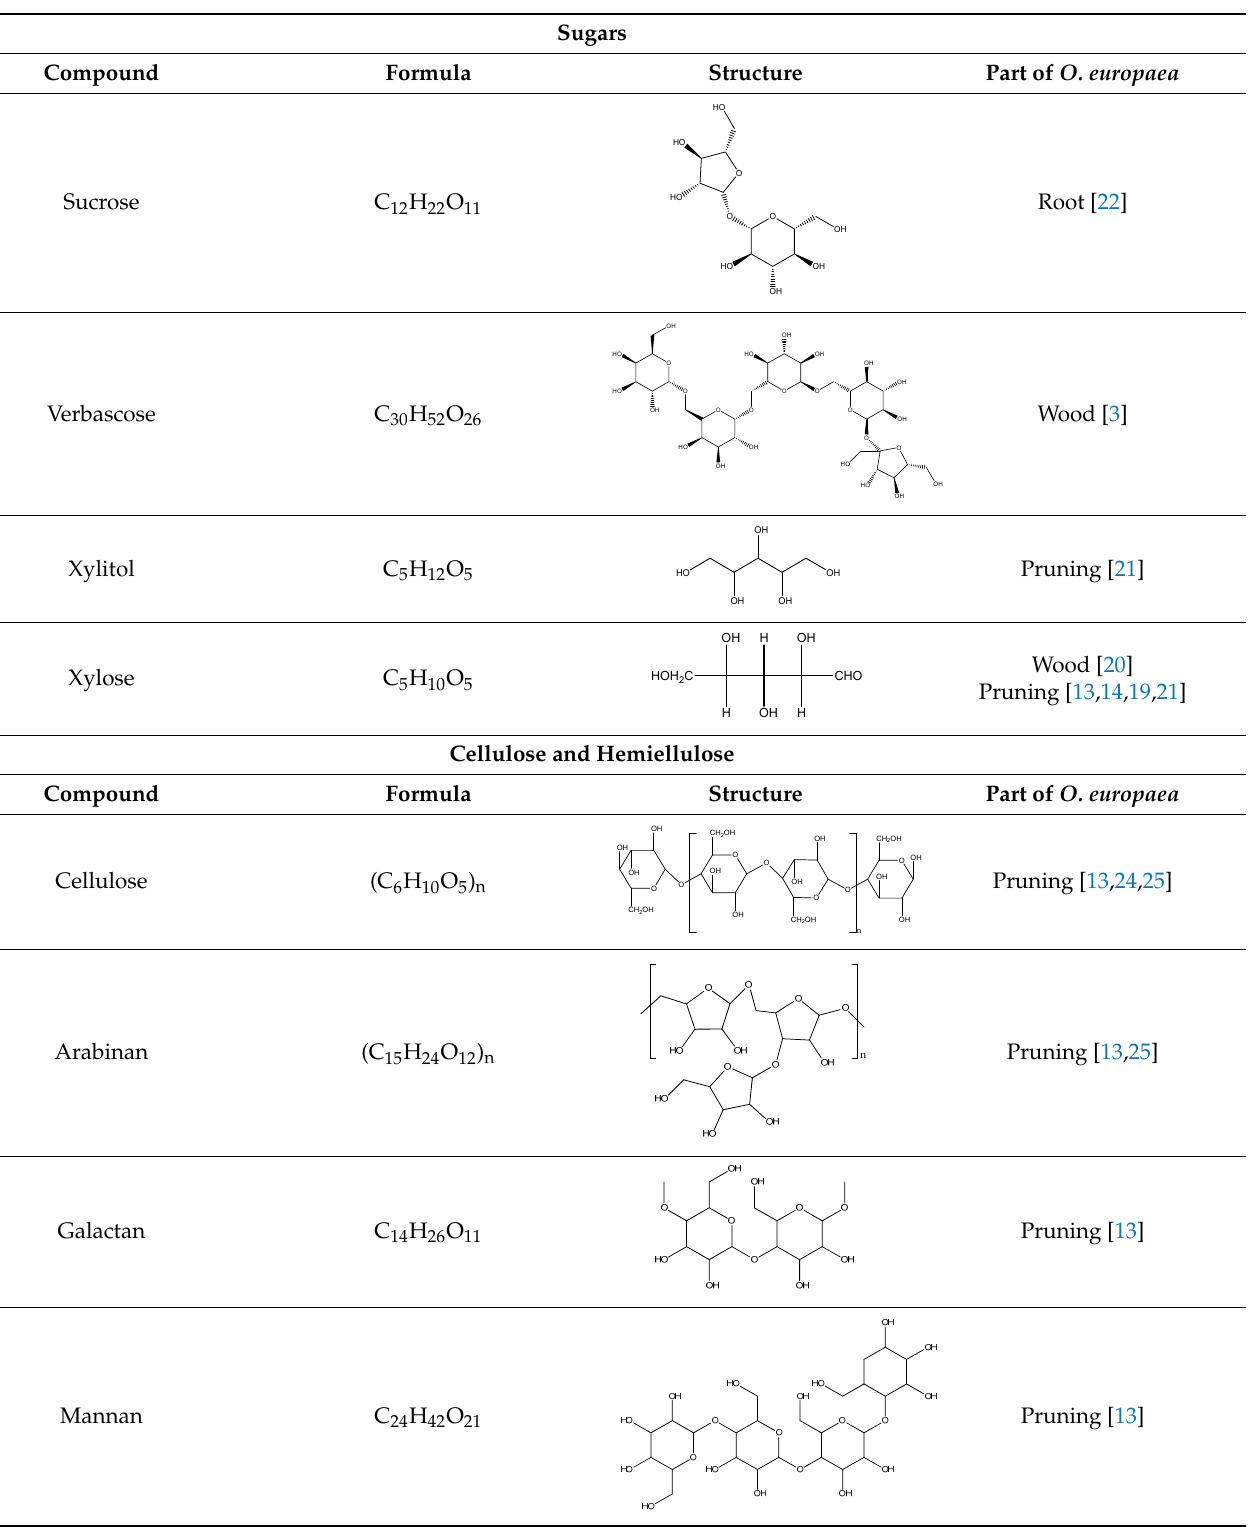
Table 1. Cont. Sugars